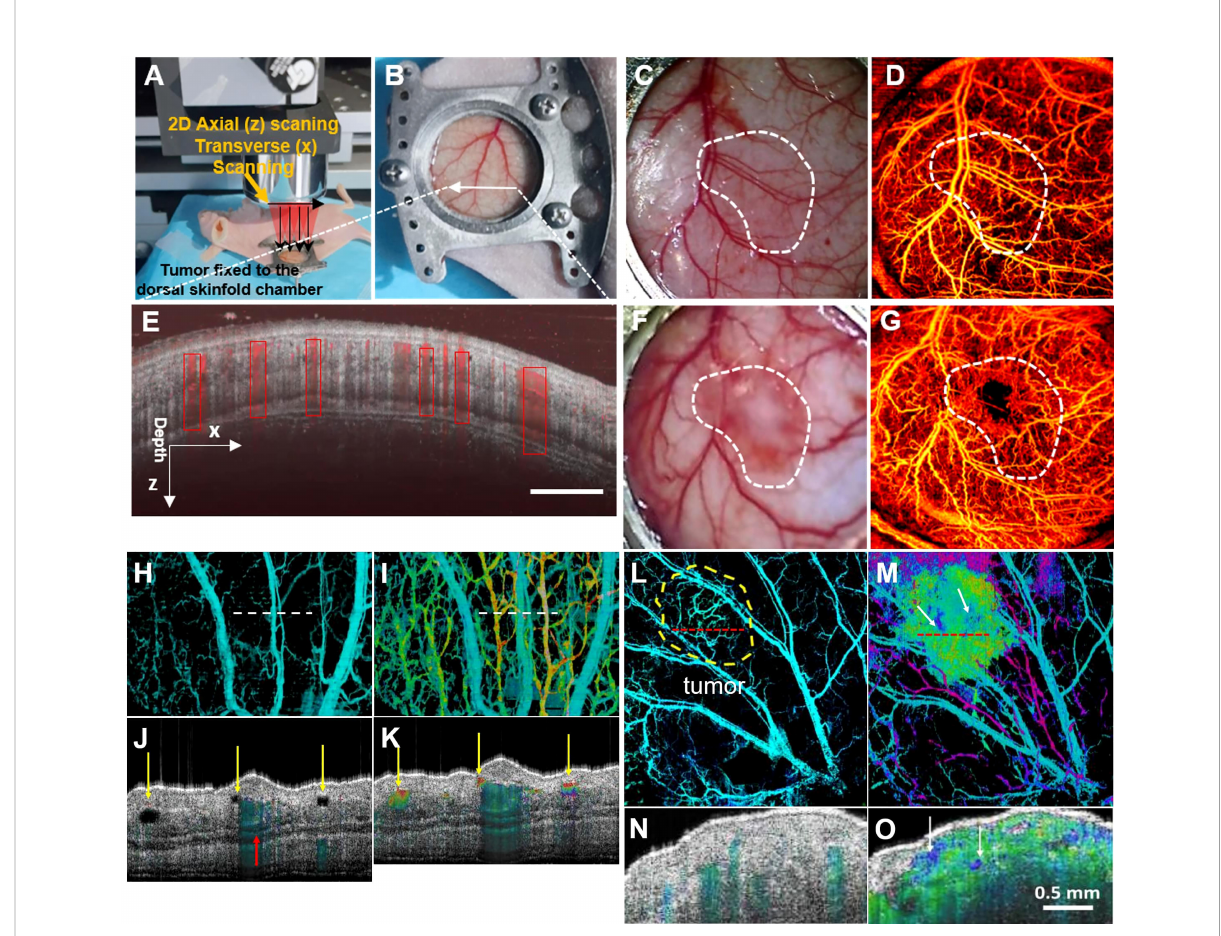
FIGURE 3 (A) Schematic of subcutaneous tumor-bearing nude mice dorsal window imaging; (B) Subcutaneous tumors of nude mice with tumors enlarge the skin window chamber images; (C) The zoom-in skin window chamber image in the healthy nude mice; (D) The corresponding enface microvascular image in vivo is shown in (C) ; (E) Representative tissue cross sectional structural image (gray) and blood fl ow image (red border); (F) The zoom-in skin window chamber image in the subcutaneous tumor-bearing nude mice; (G) The corresponding enface microvascular image in vivo is shown in (F) (50); Copyright 2021, Wiley. (H) Normal vascular OCT images; (I) OCT images of angiogram and lymphangiography. The dotted line indicates the position of the cross-section image in A-B. (J, K) normal angiography and lymphangiography OCT en-face images. The red arrow indicates a large blood vessel, and the yellow arrow indicates the lymphatic vessel. (L) Melanoma vascular OCT image. (M) OCT images of melanoma angiography and lymphangiography. The dotted line indicates the position of the cross-section image in (E – F) . (N, O) Melanoma angiography and lymphangiography OCT en-face image (52). Copyright 2020, American chemistry